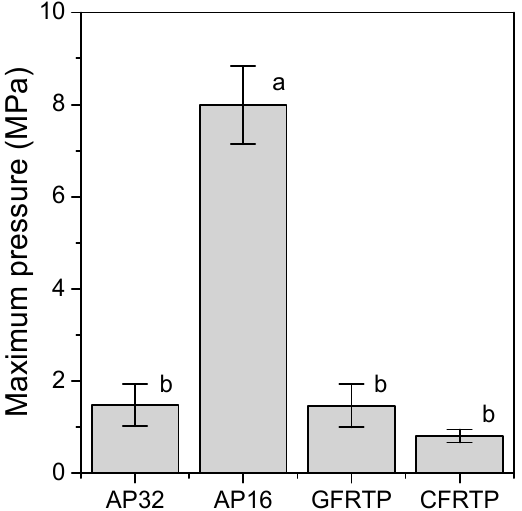
Figure 5. Pressure histograms obtained using pressure measurement films. ( A ) AP32, ( B ) AP16, ( C ) GFRTP, and ( D ) CFRTP.